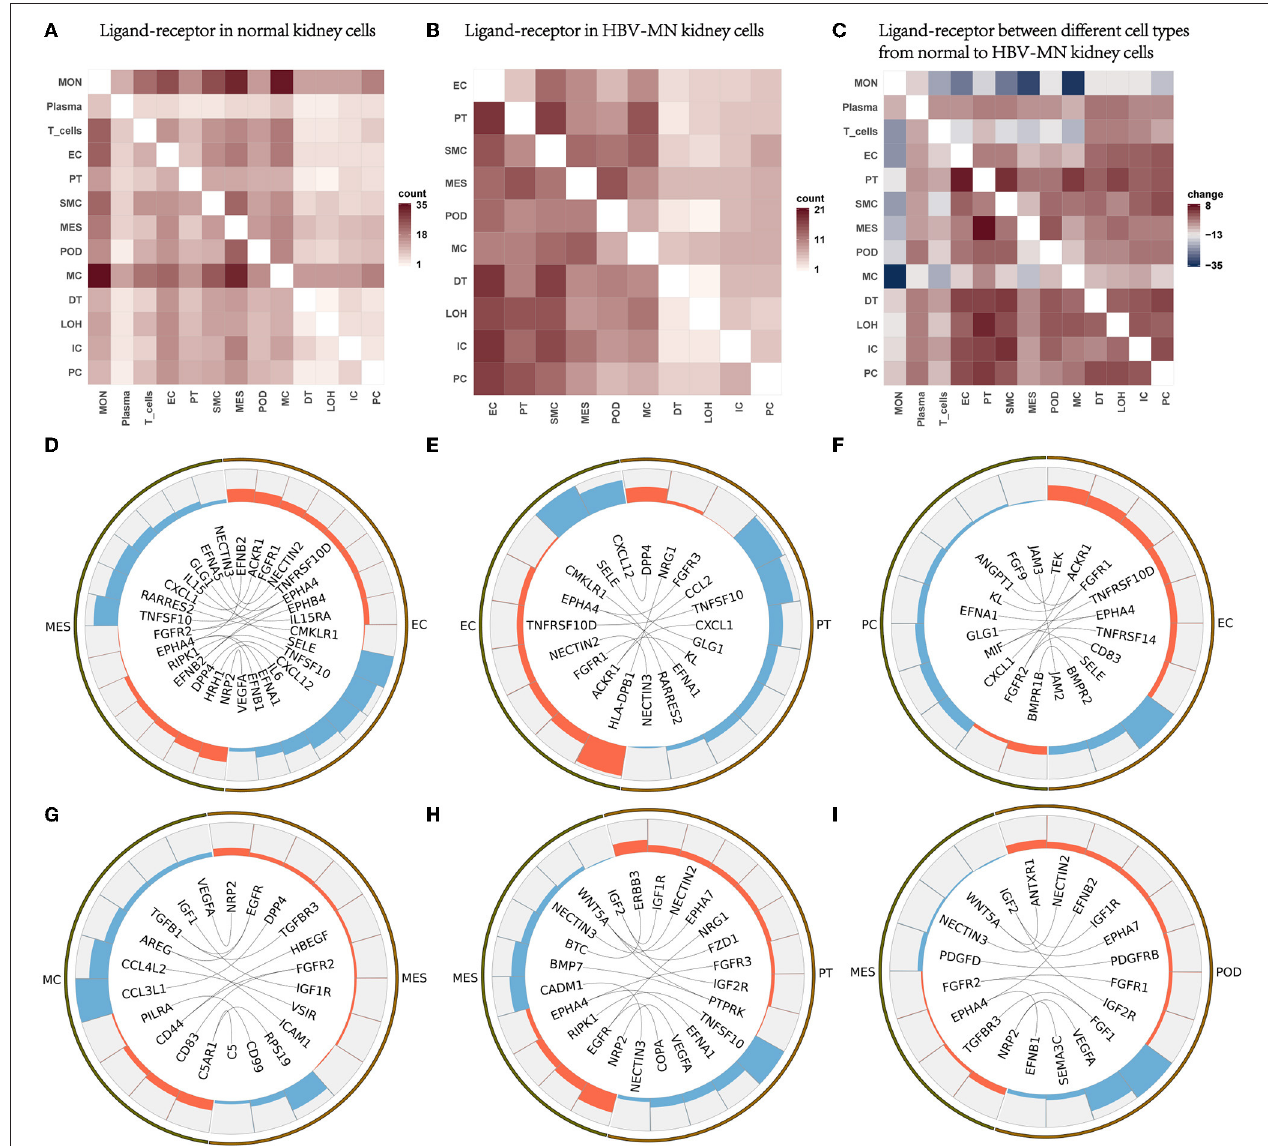
FIGURE 5 | Ligand-receptor interactions in the kidney of HBV-MN and healthy subjects. (A) Ligand-receptor signaling pathways between cell clusters in healthy kidney cells. Cell-cell crosstalk frequency ranges from low (white) to high (red). (B) Ligand-receptor signaling pathways between cell clusters in HBV-MN kidney cells. Cell-cell crosstalk frequency ranges from low (white) to high (red). (C) Ligand-receptor between different cell types from normal to HBV-MN kidney cells. Cell-cell crosstalk frequency difference ranges from low (blue) to high (red). (D–I) Representative ligand-receptor interactions in EC-MES, EC-PC, EC-PT, MES-MC, MES-PT, MES-Pod. Lines represented interrelations between